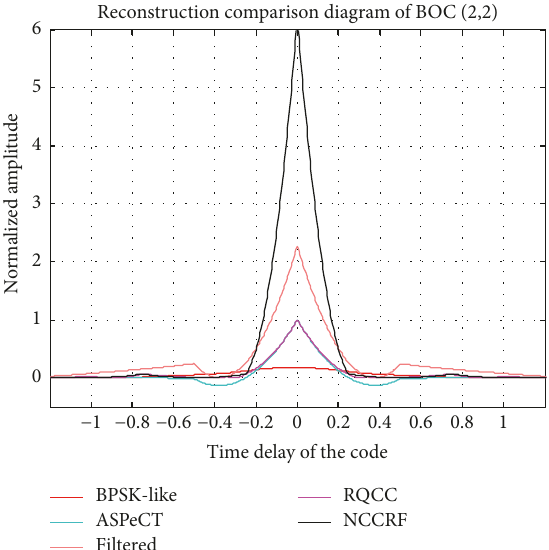
Figure 4: The reconstruction comparison of BOC ( 6, 1